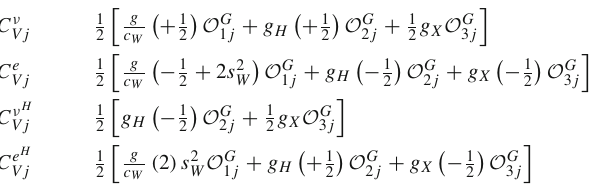
( 1 ) X is the U X and C f for both the Lj Rj